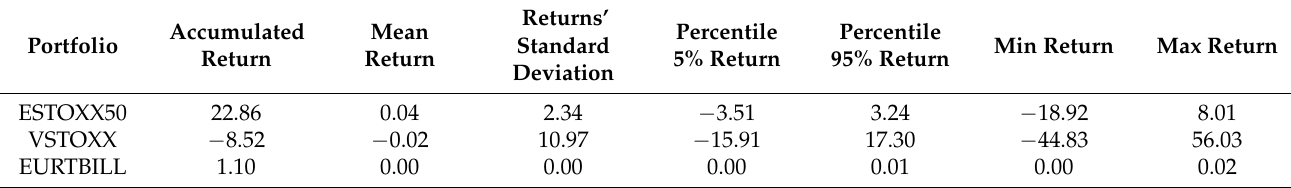
Table 4. The historical and accumulated performance of a buy-and-hold investment strategy in the three types of securities of interest in our simulations.